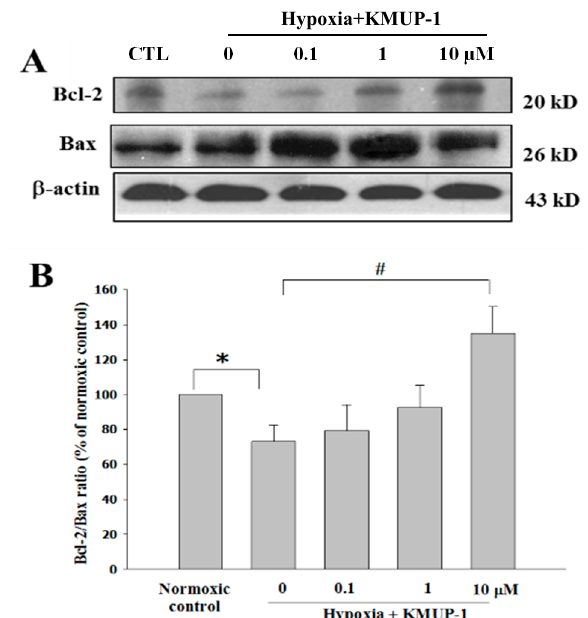
Figure 6. E ff ect of KMUP-1 on the ratio of Bcl-2 / Bax proteins expression in H9c2 cardiomyoblasts induced by hypoxia. ( A ) Western blot analysis of Bcl-2 / Bax proteins ratio were performed on whole protein extracts from H9c2 cardiomyoblasts cultured without sera and treated with hypoxia (24 h). ( B ) Quantitative analysis on the ratio of Bcl-2 / Bax proteins expression in H9c2 cardiomyoblasts during hypoxia (24 h). Results are presented as mean ± SEM from three independent experiments. * p < 0.05 vs. normoxic control, # p < 0.05 vs. hypoxic control.